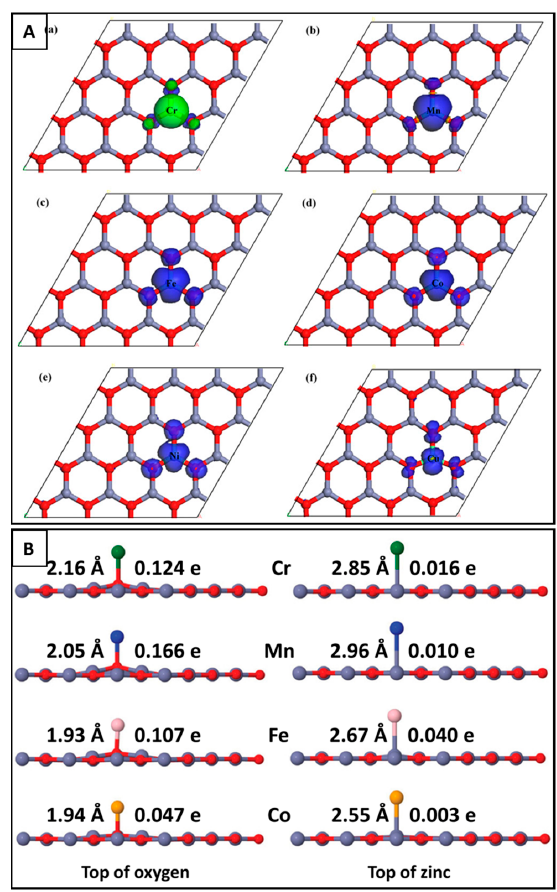
Figure 6. Transition metal–doped and decorated graphene-like zinc oxide mono-layers. Panel ( A ): ( a – c ) The spin charge density distribution of Cr-, Mn-, Fe-, Co-, Ni-, and Cu-doped g-ZnO mono-layers, respectively. The blue and green colors represent positive (spin-up) and negative (spin-down) values, respectively. Reprinted with permission from Reference [28]. Copyright © (2013) John Wiley and Sons. Panel ( B ): Atomic structures of Cr, Mn, Fe and Co adsorbed on g-ZnO mono-layers. The configurations of TM adsorbed on top of oxygen and on top of zinc are represented on the left and right structures, respectively. In each structure, the length of the TM-O (or TM-Zn) bond and the charge transfer value from TM to its nearest-neighbor O (or Zn) are denoted on the left and right side of the adsorbed TM atoms, respectively. Reprinted with permission from Reference [29]. Copyright © (2015) AIP Publishing LLC.